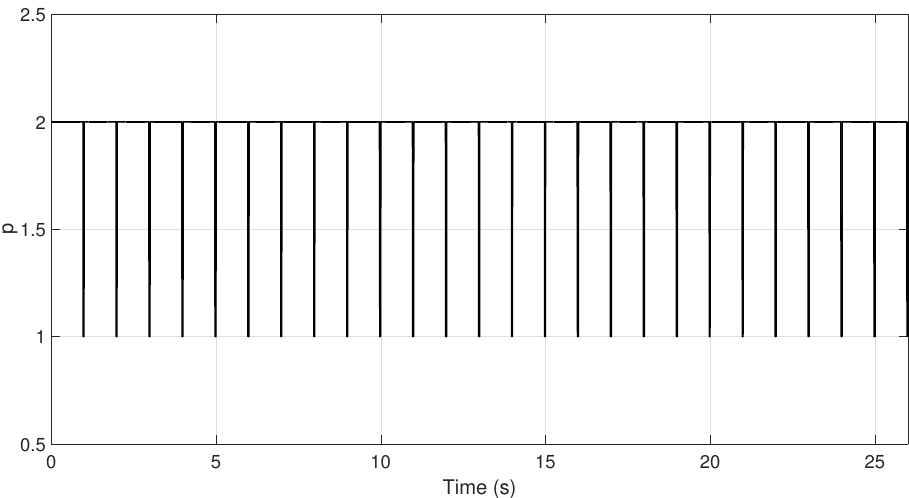
Figure 2. Arbitrary switching law that unstabilizes the system’s trajectories.